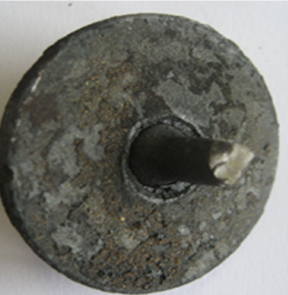
Figure 9. Photo of the 50H21G9N4 steel sample after exposure in the boiler combustion chamber.